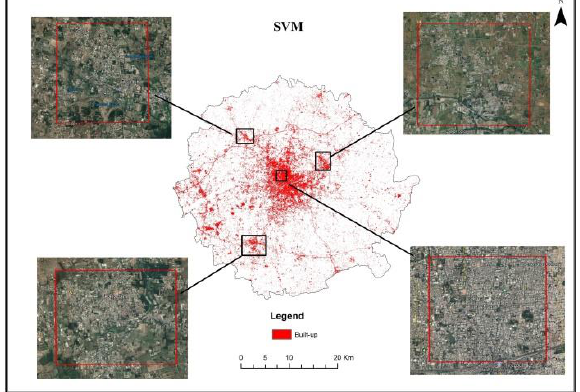
Figure 6. Kappa Coefficient & Overall Accuracy